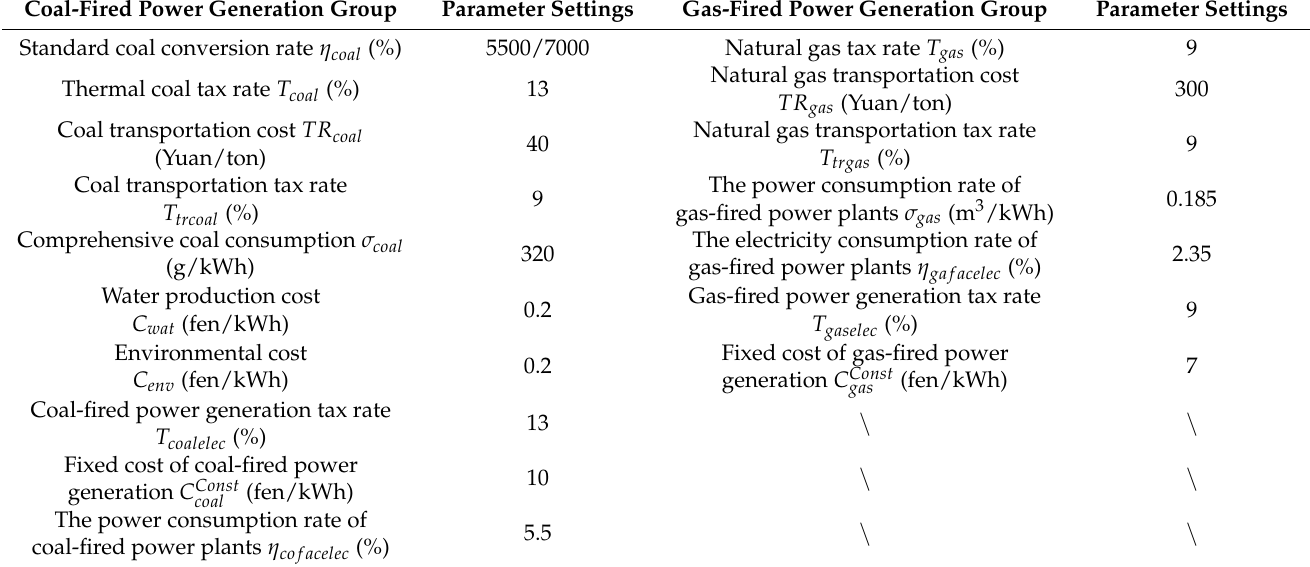
Table 5. Parameter settings of the tax rate, freight, and power plant.